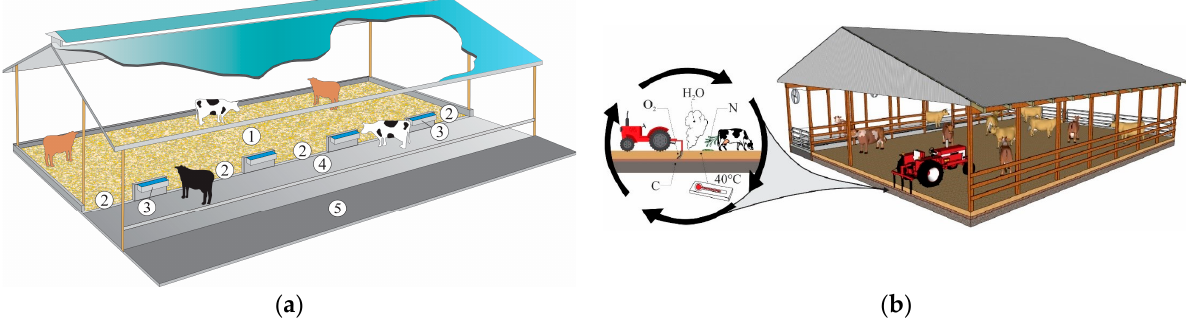
Figure 1. Schematic representations of a compost barn system. ( a ) 1—rest area with organic compost-bed; 2—free passage area; 3—water trough; 4—feeding area; 5—feeder. ( b ) Bed turning management. Figures adapted with permission from Ref. [23] (in Portuguese: compost barn como alternativa para a pecuária leiteira), 2020, Flávio Alves Damasceno.